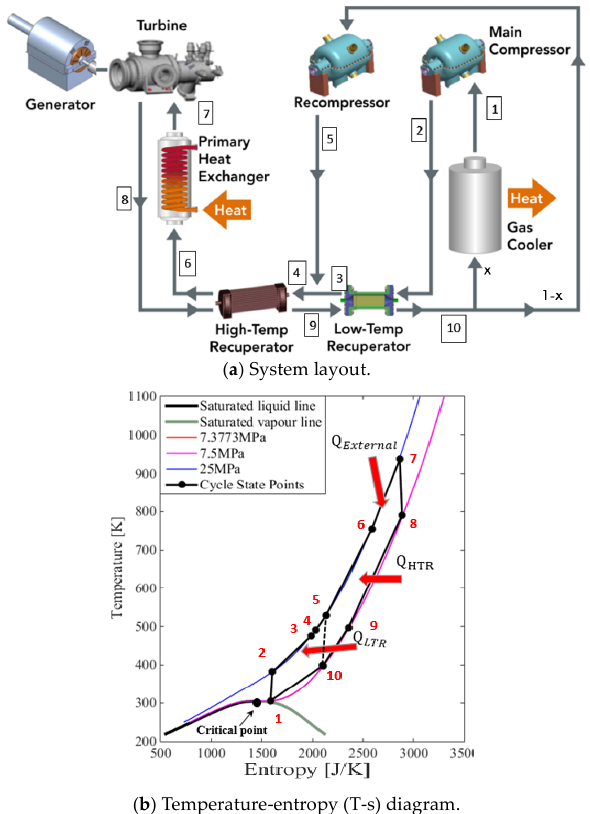
Figure 1. Schematic of re-compression (cid:1871)(cid:1829)(cid:1841) (cid:2870) Brayton cycle.